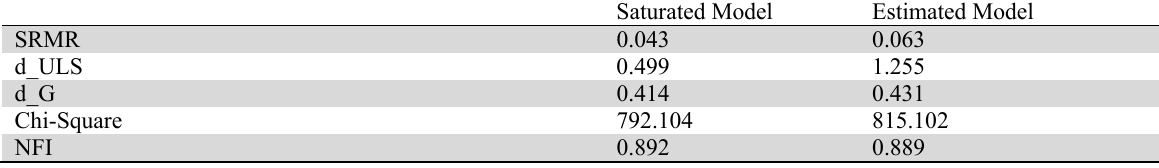
Model Fit Summary